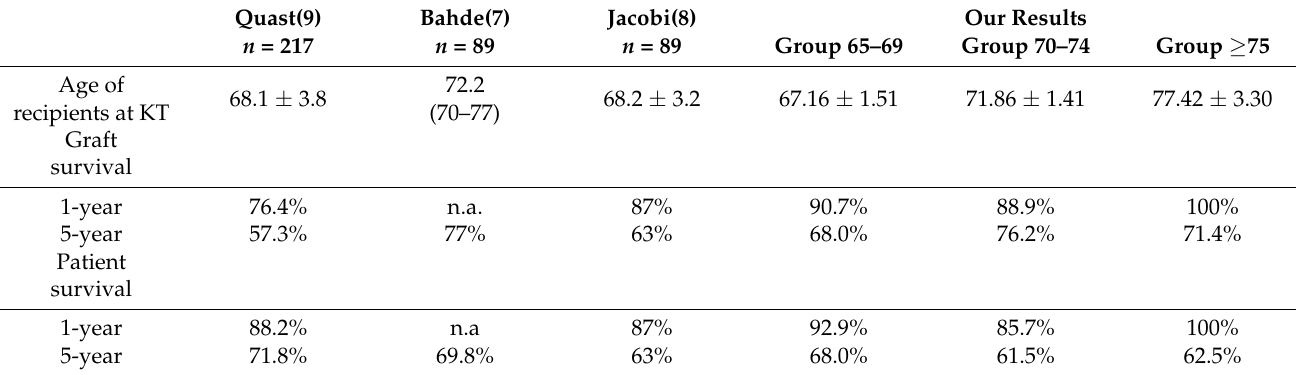
Table 5. Comparison of death-censored graft and patient survival in the Eurotransplant Senior